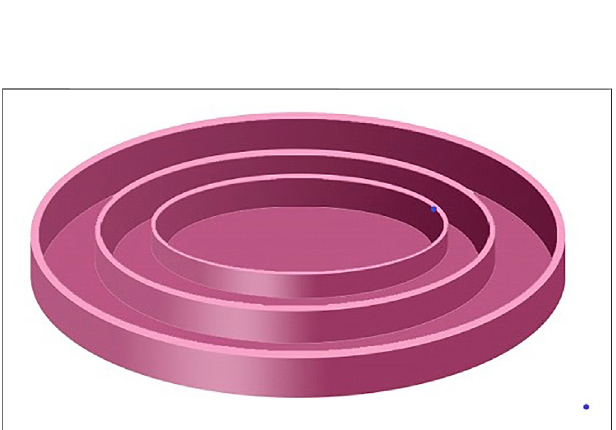
FIGURE 3 | Composite structure of the metasurface model used in the